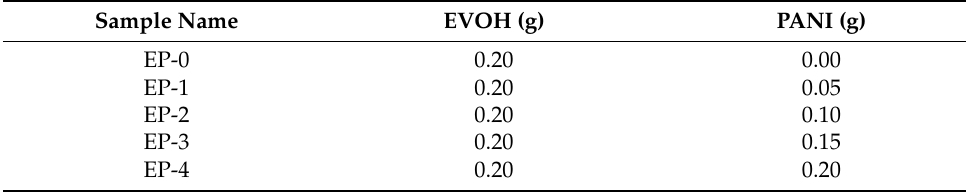
Figure 1. The schematic diagrams of the preparation of EVOH/PANI composite NFAs. Table 1. Sample name of EVOH/PANI composite NFAs. Table 1. Sample name of EVOH/PANI composite NFAs.